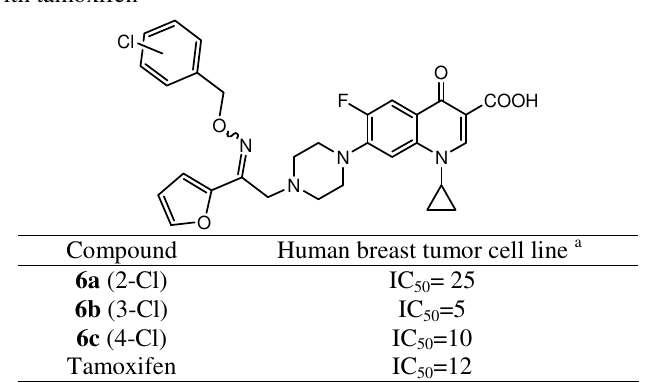
Table 1. Cytotoxic activity of compounds 6a-c against human breast tumor cell lines in comparison with